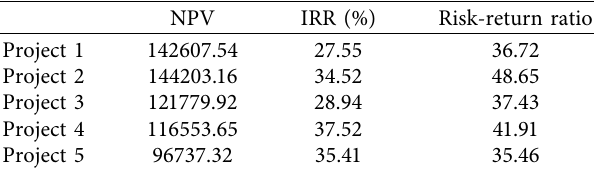
Table 5: Economic evaluation indices of different